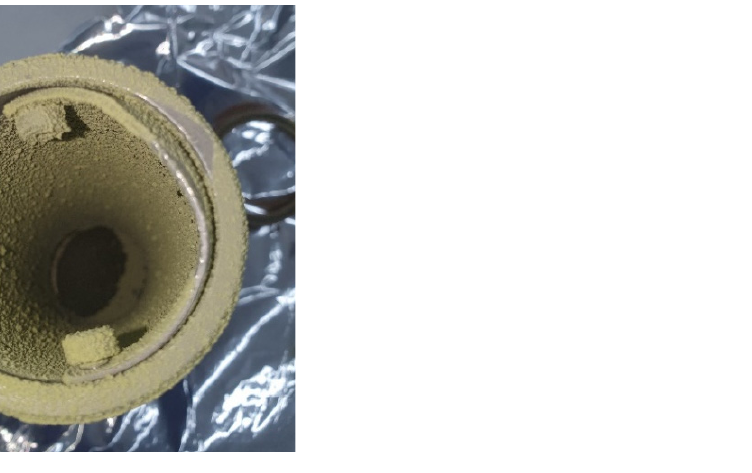
Figure 3. Precipitated powder obtained on a vessel by means of the SAE of myrtle leaf extract.